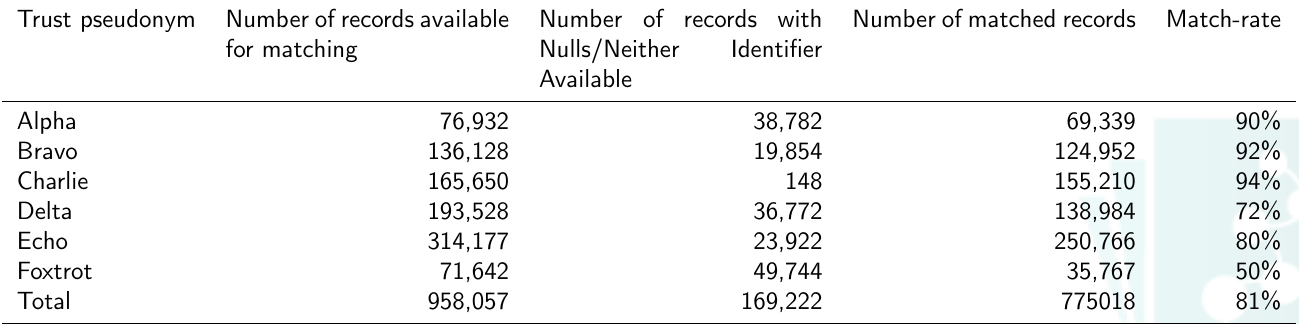
Table 4: Data completeness and linkage rate, by